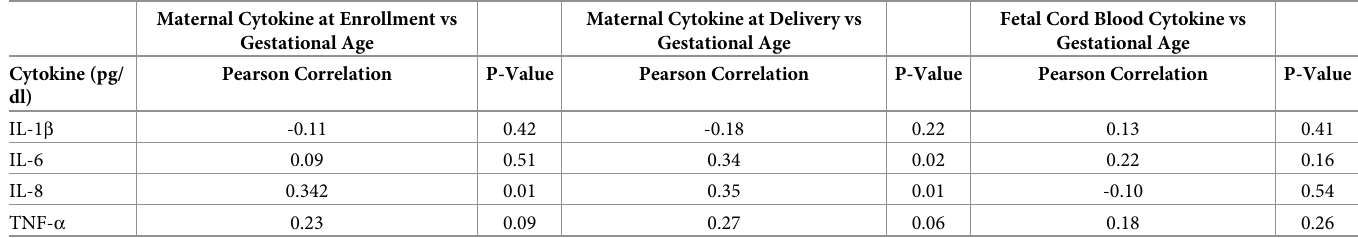
Maternal Cytokine at Delivery vs Gestational Age